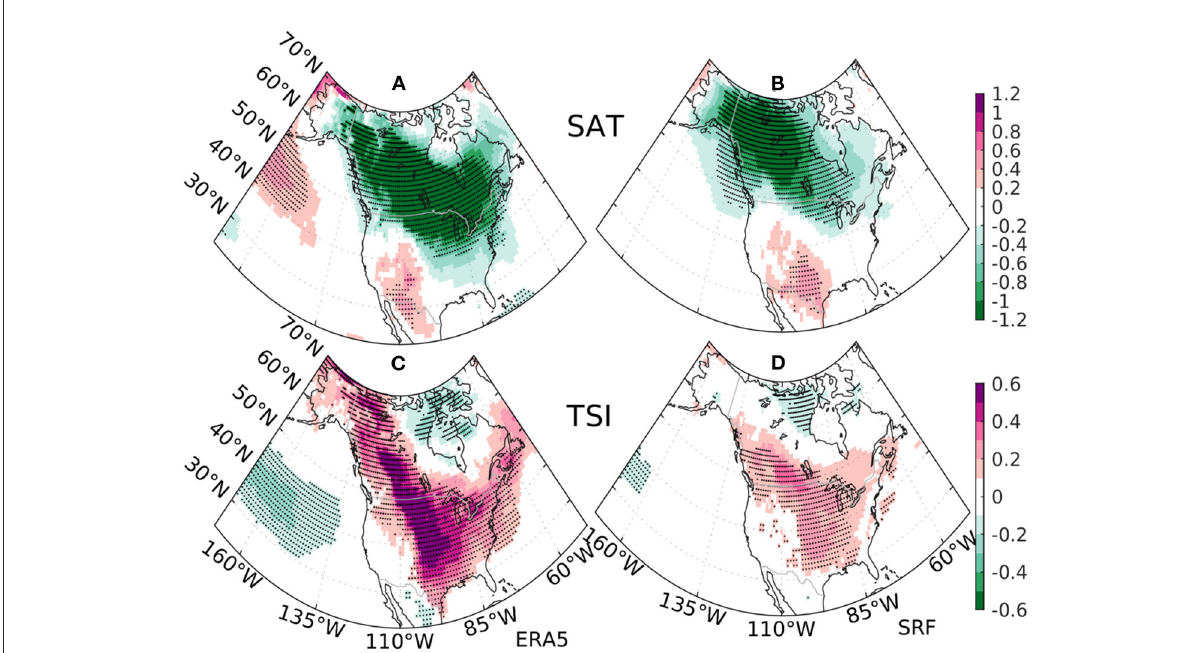
FIGURE8 The regression pattern onto the observed normalized NPO index for the DJF surface air temperature (SAT) (units in K) during 1992–2022 from (A) ERA5 reanalysis and (B) the ensemble mean estimates of SPEAR’s SRF. The same regression pattern for the DJF Temperature Swing Index (TSI) (units in K) from (C) ERA5 reanalysis and (D) the ensemble estimates of SPEAR’s SRF. The stippling indicates regression coefficients significant at 5%